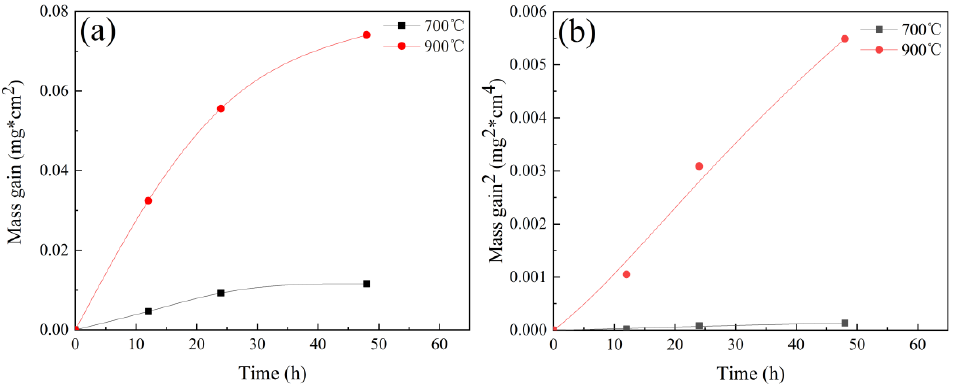
Figure 2. The mass gain of HEA: ( a ) Weight gain versus oxidation time curves; ( b ) Parabolic plot.